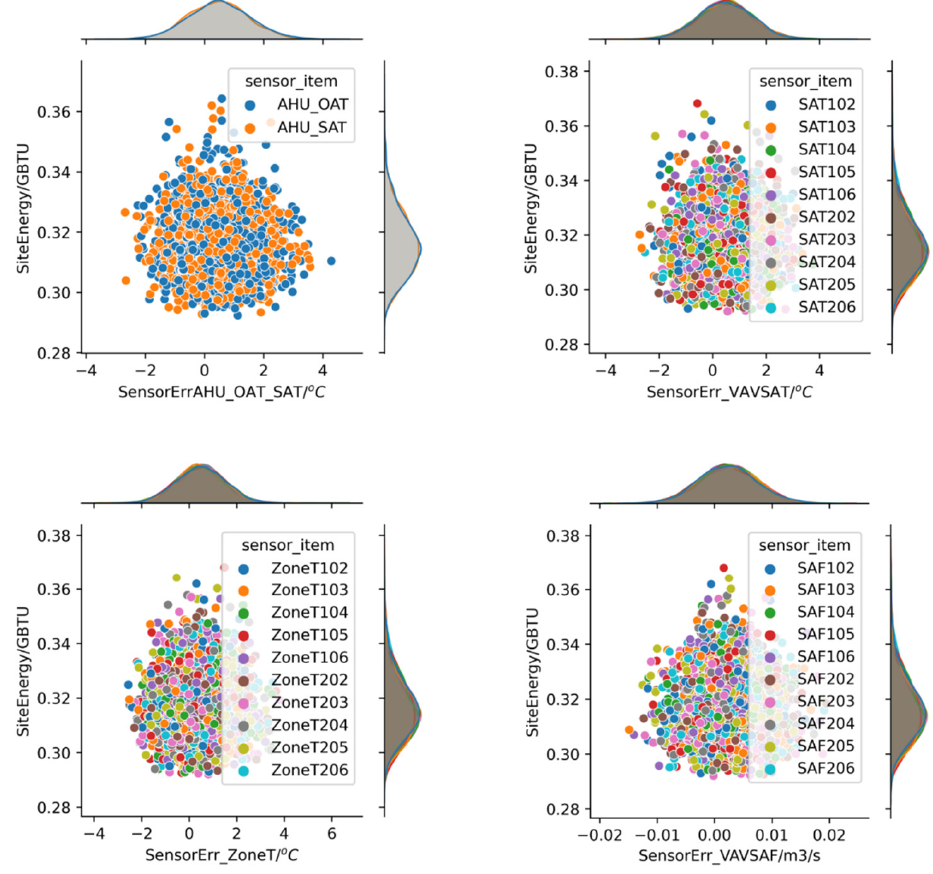
Figure 12. Site energy and sensor errors.